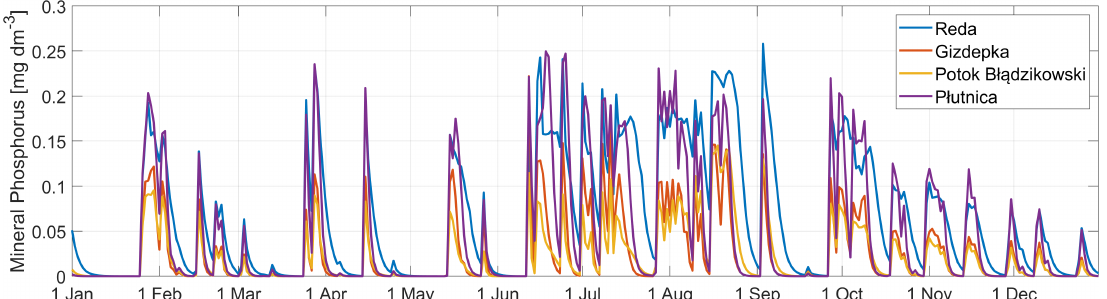
Figure 5. Average concentration of mineral phosphorous in rivers entering the Puck Bay provided by SWAT (mg dm − 3 ).